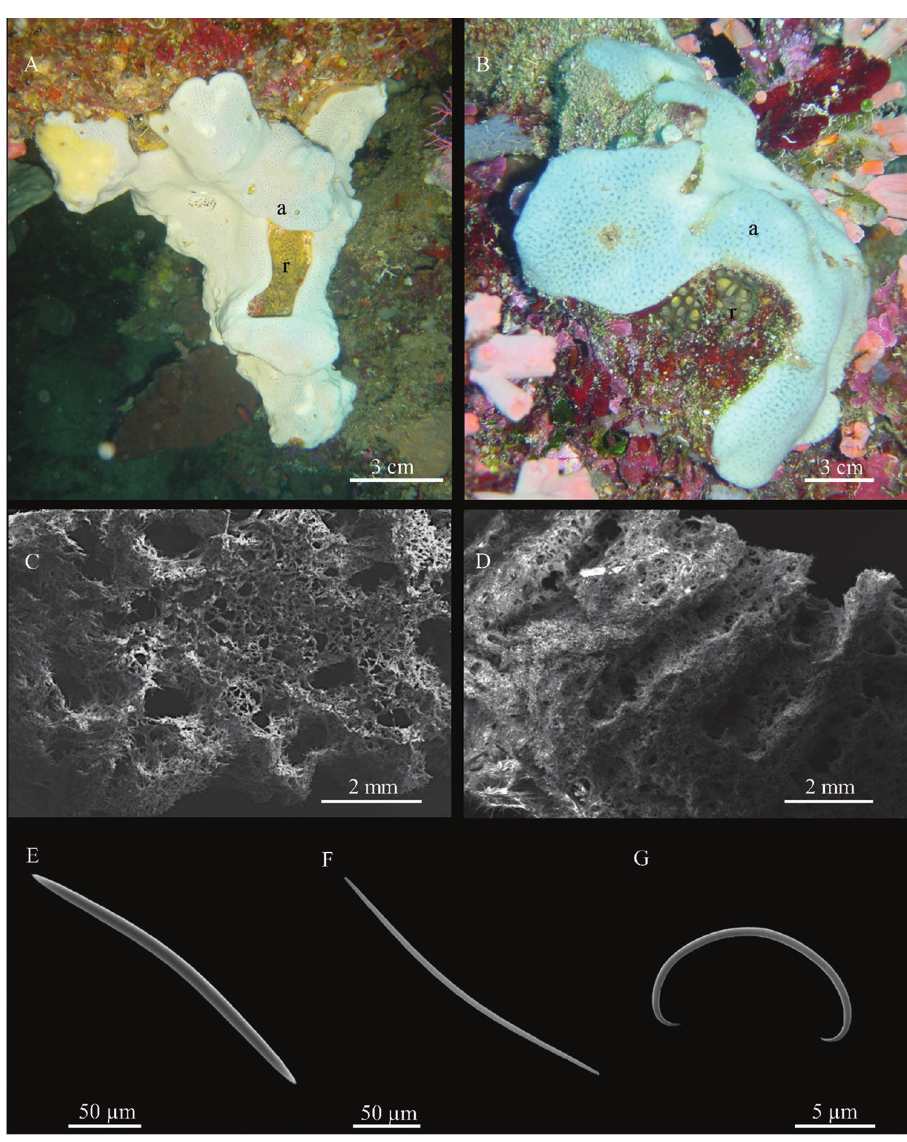
Figure 6. Amphimedon cf. sulcata Fromont, 1993 A, B specimens in situ ( a ), partially covering the asso- ciated sponge Rhabdstrella distincta ( r ), specimen BU-560a1 in Figure 6A, BU-560 in Figure 6B C SEM image of the ectosome D SEM image of the choanosome E oxea F thin oxea G